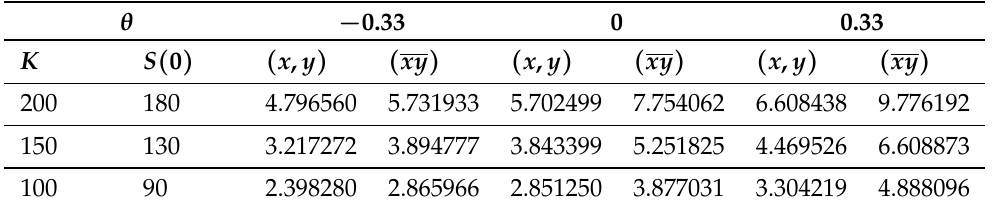
Table 3. Out-of-the-money fixed strike lookback call option for σ = 0.25, δ = 8%, µ = δ − σ 2